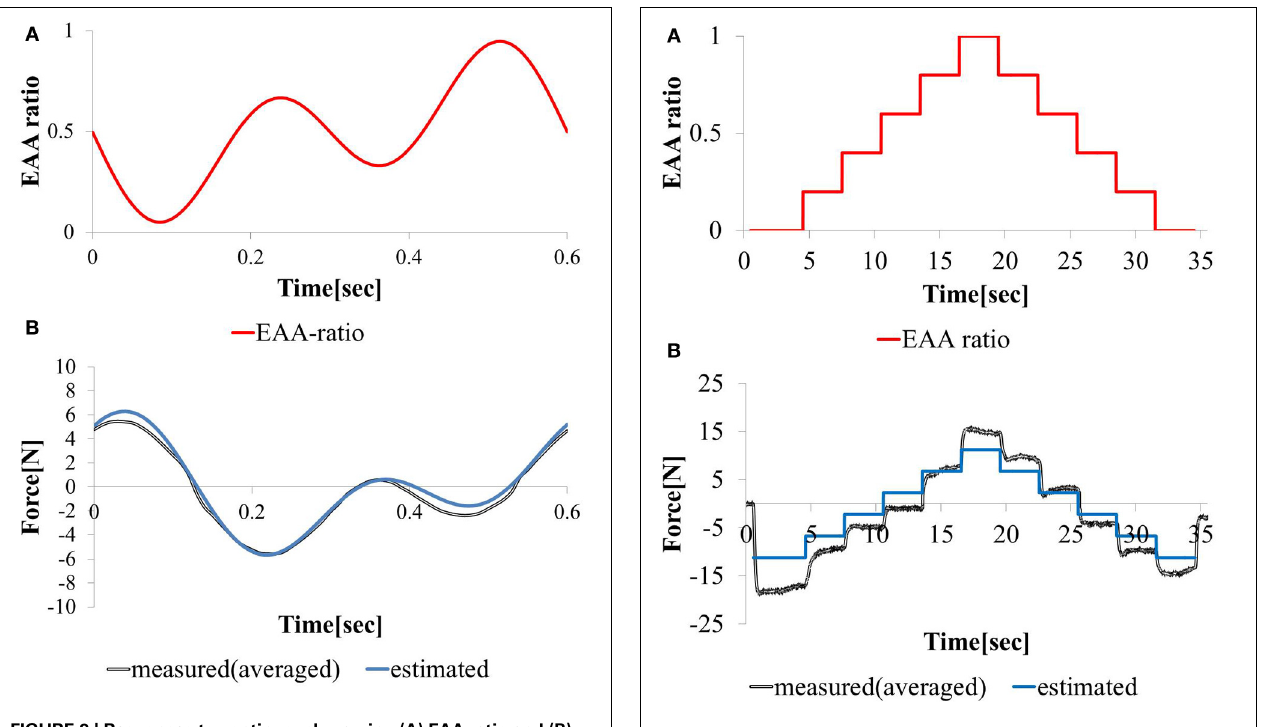
FIGURE 8 | Responses to continuously varying (A) EAA ratio and (B) estimated and measured. FIGURE 9 | Responses to stepwise varying (A) EAA ratio and (B) estimated and